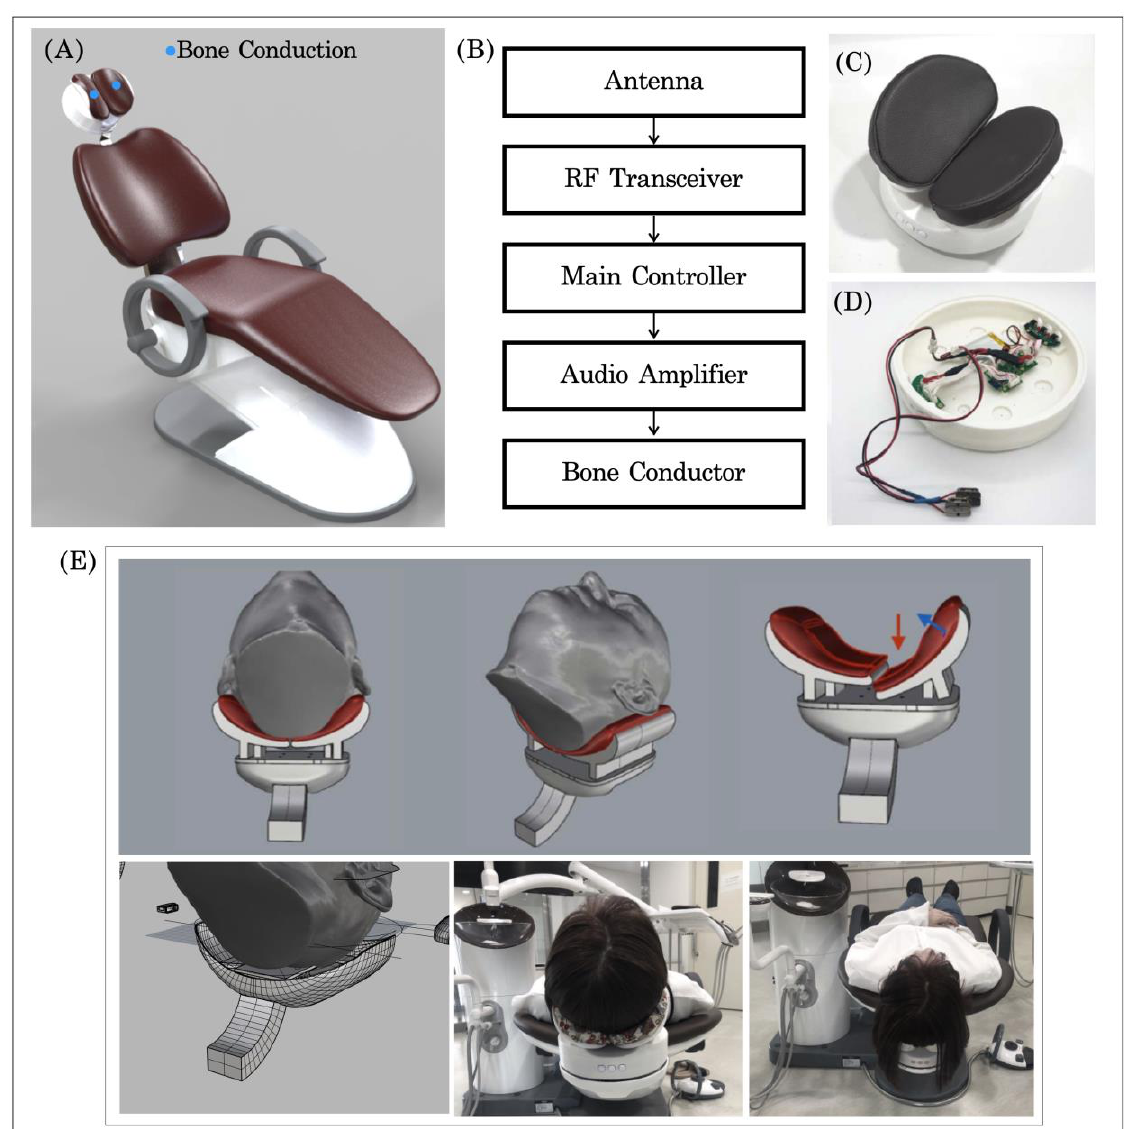
Figure 1. Configuration and photography of unit chair with bone conduction speaker: ( A ) unit chair with bone conduction; ( B ) diagram of bone conduction speaker; ( C ) headrest of unit chair; ( D ) bone conduction speaker system; ( E ) double-sided headrest designed to wrap around the head using the weight of the user ′ s head.